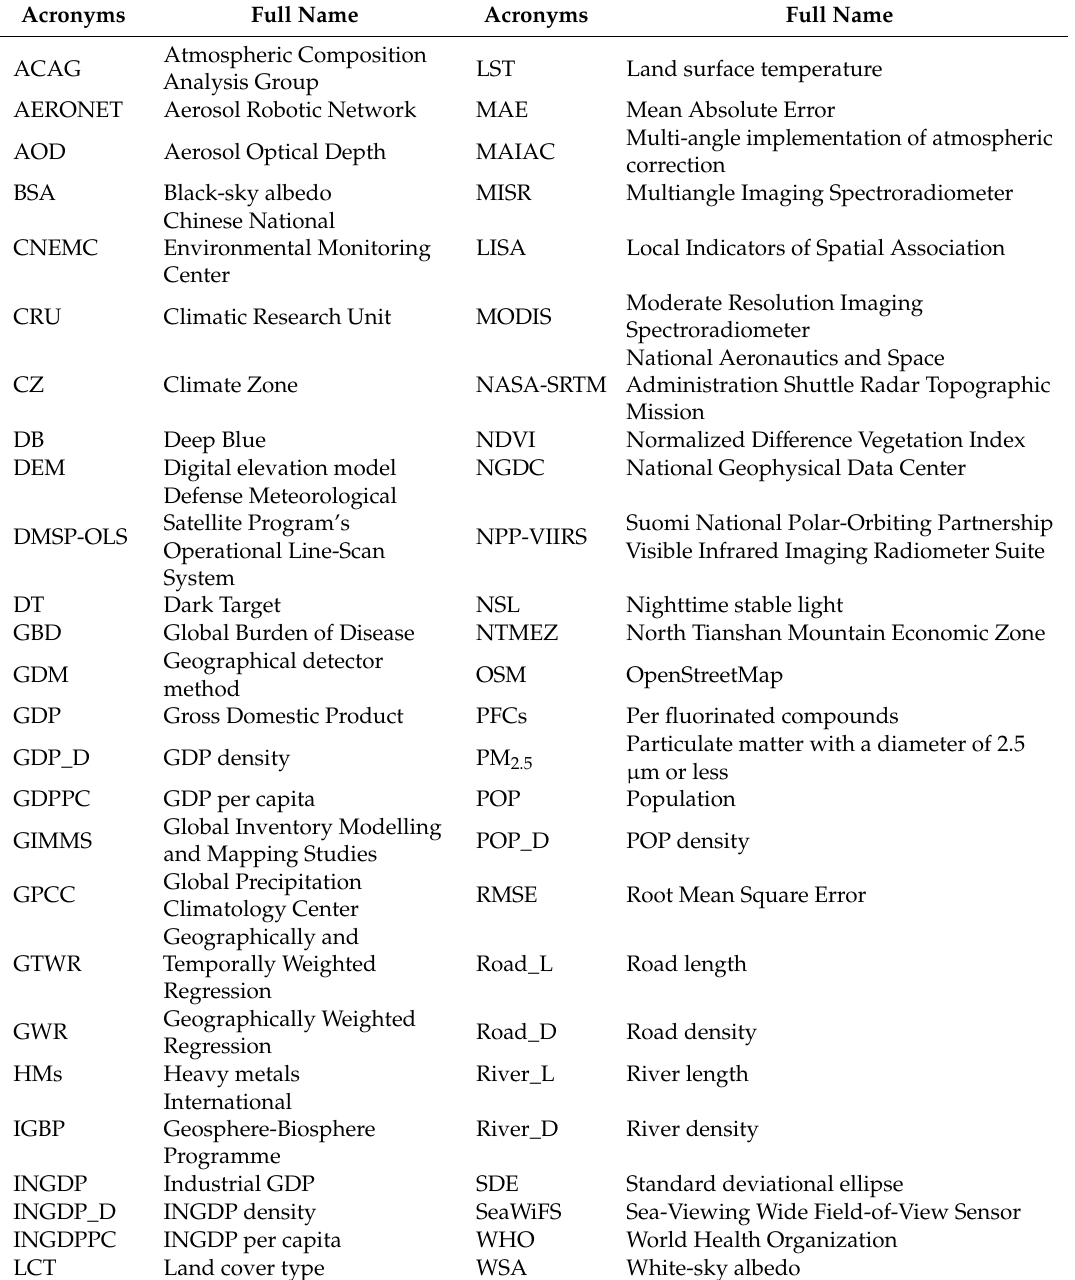
Table 2. Complete list of acronyms with corresponding full names used in this